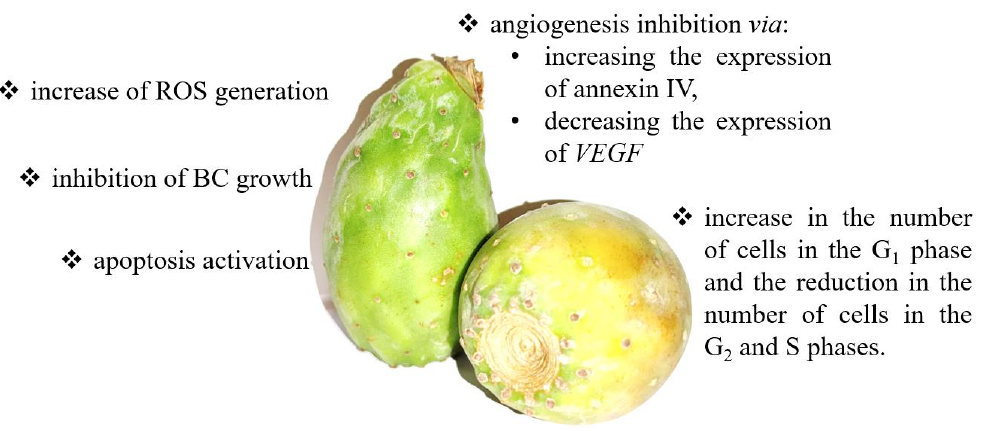
Figure 4. The summary of the anticancer effects and mechanisms of cactus pear action. Cactus pear may modulate numerous signaling pathways, including apoptosis [129], cell growth [128], angiogenesis [128], cell cycle [128], and ROS generation [129].